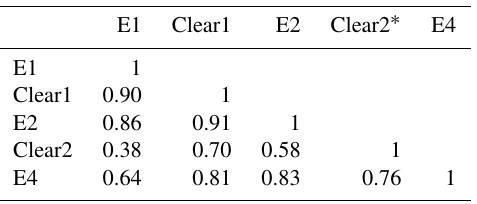
Table 2. Correlations of number fractions of particle types in differ- ent events at